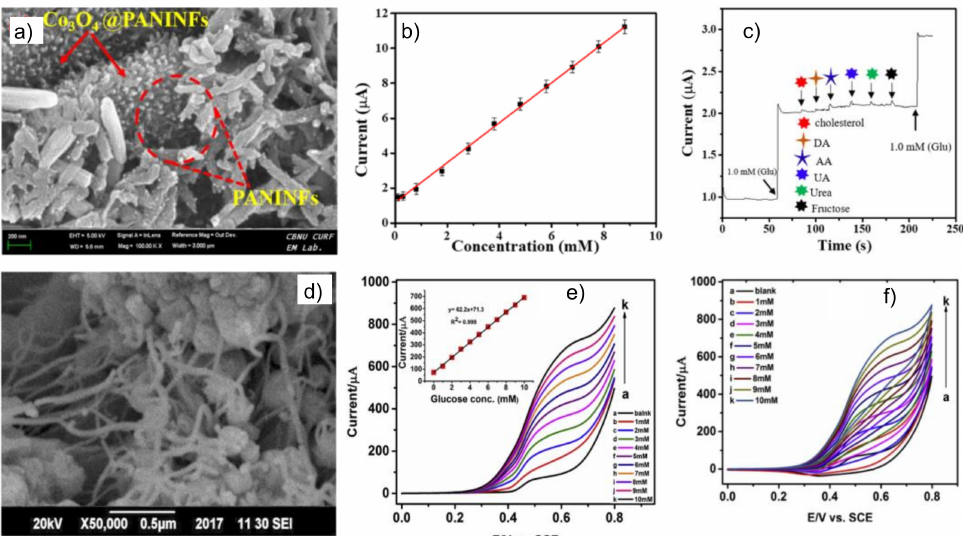
Figure 11. Non-enzymatic Co 3 O 4 @PaniNFs sensor: ( a ) FE-SEM view of composite, ( b ) calibration curve for glucose detection, and ( c ) selectivity of the device; PAni@CuNi sensor: ( d ) SEM image of the nanocomposite, glucose detection in 0.1 NaOH using LSV ( e ) and CV ( f ); The figure was adapted from references Bilal et al. [103] and Yassin et al. [104].